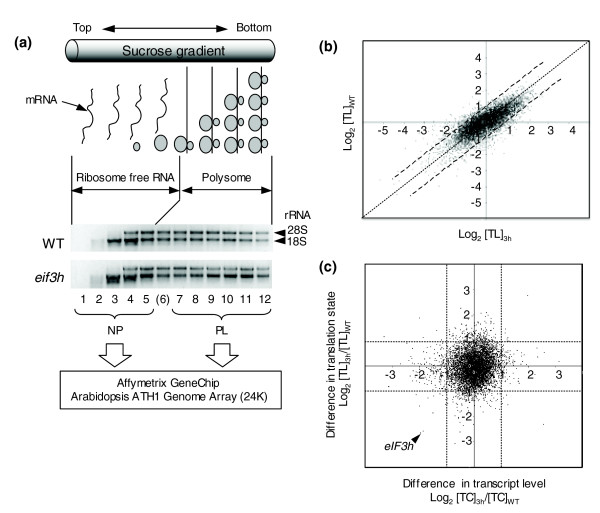
Microarray analysis of polysome loading in the eif3h mutant. (a) Experimental design for the isolation of polysomal (PL) and non-polysomal (NP) RNAs. After sucrose density gradient centrifugation, samples were collected into 12 fractions. The integrity of the density gradient was confirmed by agarose gel electrophoresis and visualization of ribosomal RNAs with ethidium bromide. Microarray probes were generated from pooled samples as indicated. (b) Log2 transformed average translation states (TL = PL/NP) of the eif3h mutant were plotted against the data from wild-type plants. (c) Effects on polysome loading by the eif3h mutation (Log2 [TL]3h/[TL]WT) were not generally correlated with effects on transcript levels (Log2 [TC]3h/[TC]WT). An arbitrary two-fold cut-off was applied to highlight responsive genes (dotted lines). The number of genes affected both transcriptionally and translationally is very small (25 out of 6,238 genes for which reproducible data were available). Among them, the eIF3h mRNA is indicated by an arrow head.